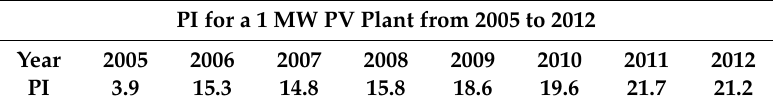
Table 9. The PI for a 1MW PV plant from 2005 to 2012.